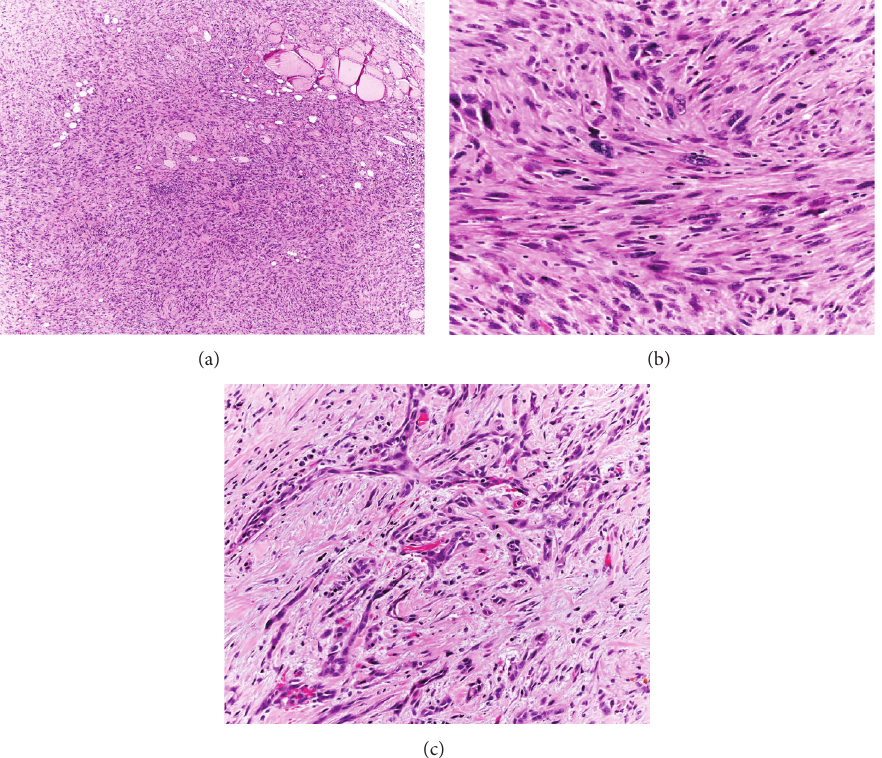
Figure 3: (a) In sarcomatoid ATCs, neoplastic cells are morphologically indistinguishable from a primary sarcoma. At higher power view (b), spindle cells are pleomorphic and show a storiform pattern of growth. (c) Anastomosing cords of neoplastic cells resembling neoplastic vessels are the dominant features in this